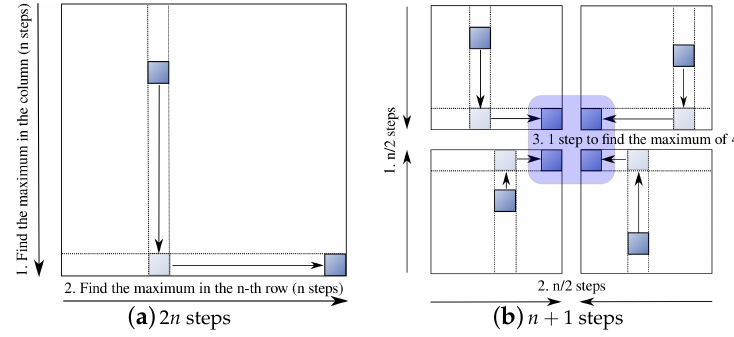
Figure 9. Maximum finding in 2D